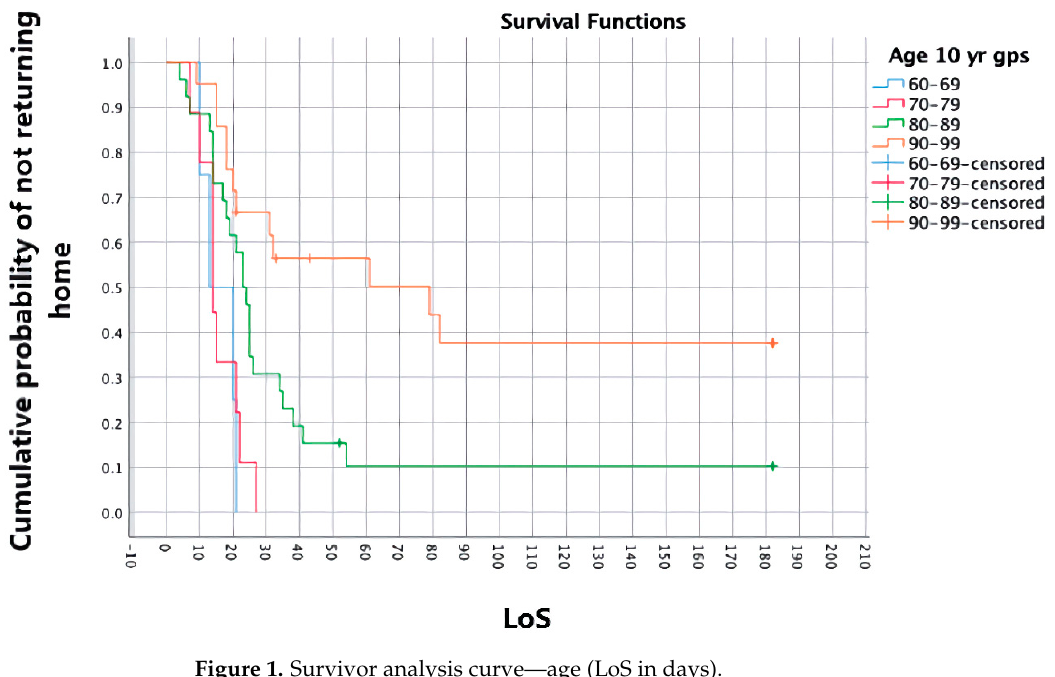
Figure 1. Survivor analysis curve—age (LoS in days).